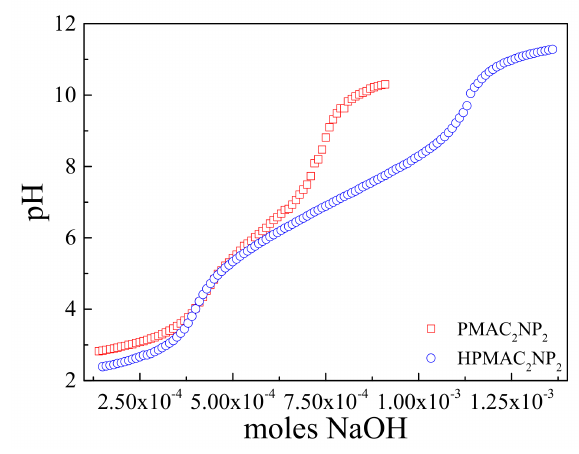
Figure 2. The titration curves for the PMAC 2 NP 2 ( (cid:3) ) and HPMAC 2 NP 2 (